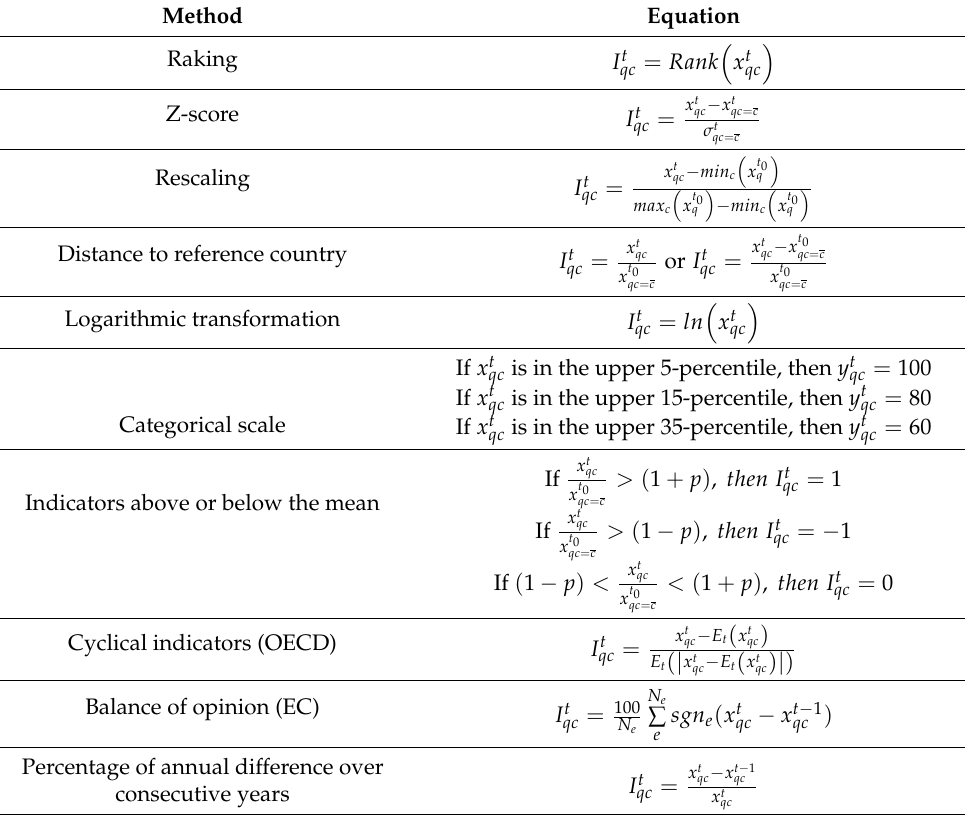
Table 2. Standard equations used to develop the complex index describing